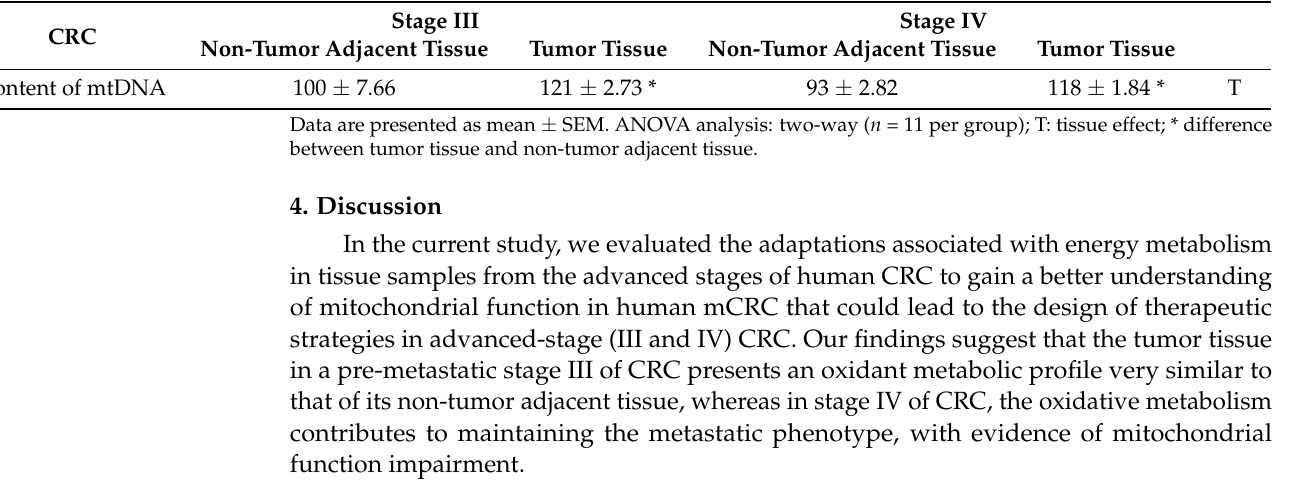
Table 1. mtDNA quantification in tissues from stage III and IV of human CRC. Stage CRC